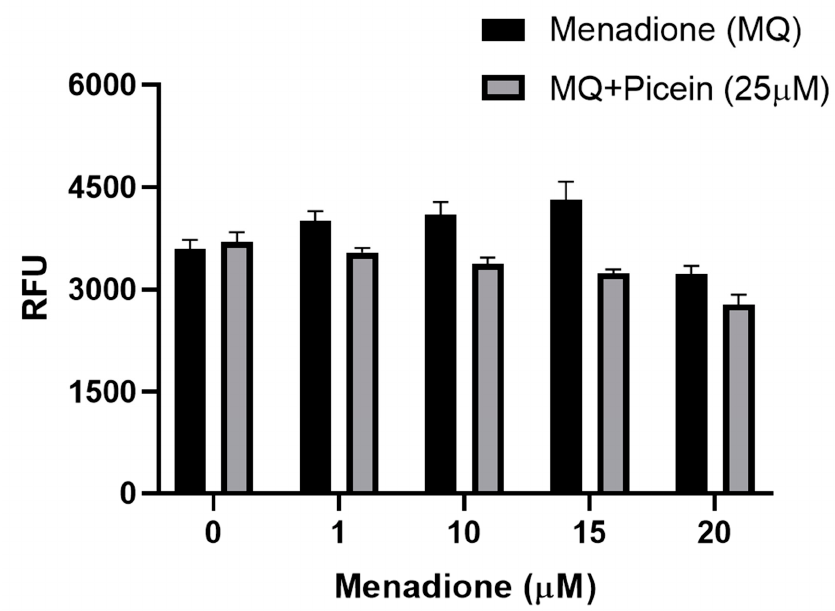
Figure 5. Reactive oxygen species level in human SH-SY5Y neuroblastoma cells were measured after menadione (MQ) treatment and follow-up treatment with picein. The data are presented as mean ± SEM. To give evidence for the statistical variations, factorial ANOVA was applied to examine the p -values for each factor, where three experiments with three samples per group were considered. Statistically significant di ff erences were examined for picein ( p < 0.0001) and MQ ( p < 0.0001). RFU indicates relative fluorescence